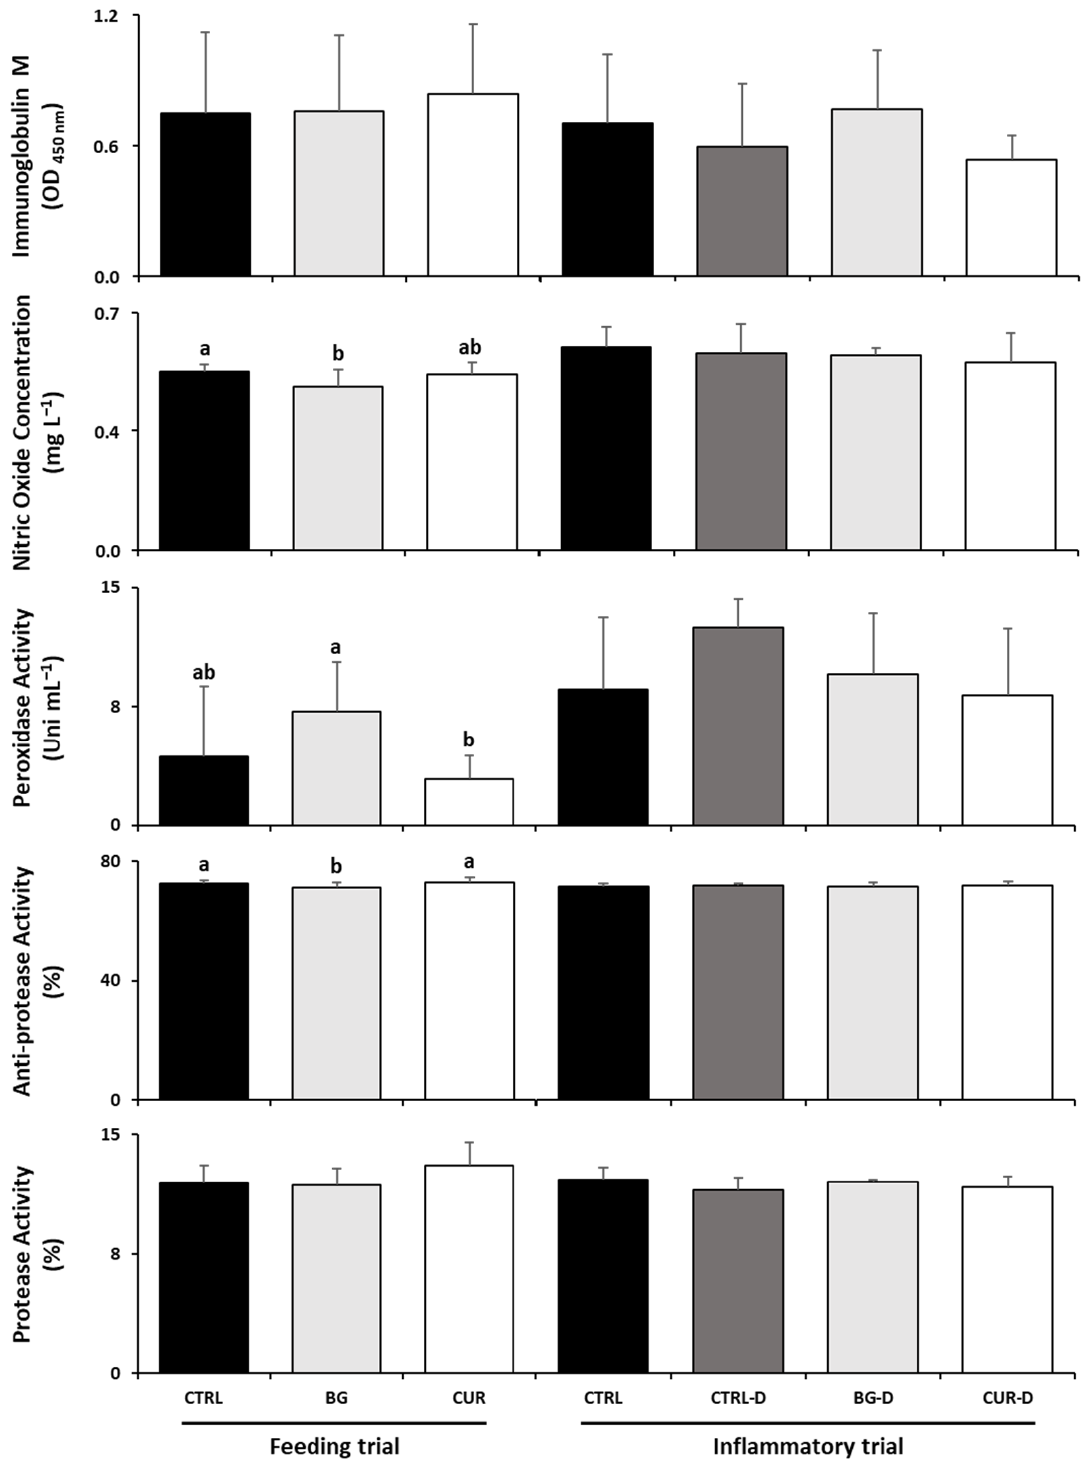
Figure 3. Humoral immunological parameters in plasma of gilthead seabream after the feeding and inflammatory trials ( n = 12). CTRL (control diet), BG (β-glucans diet), CUR (curcumin diet), CTRL-D (control diet + dextran sodium sulphate − DSS), BG-D (β-glucans diet + DSS), CUR-D (curcumin diet + DSS). Different letters mean significant differences among dietary treatments ( p < 0.05).